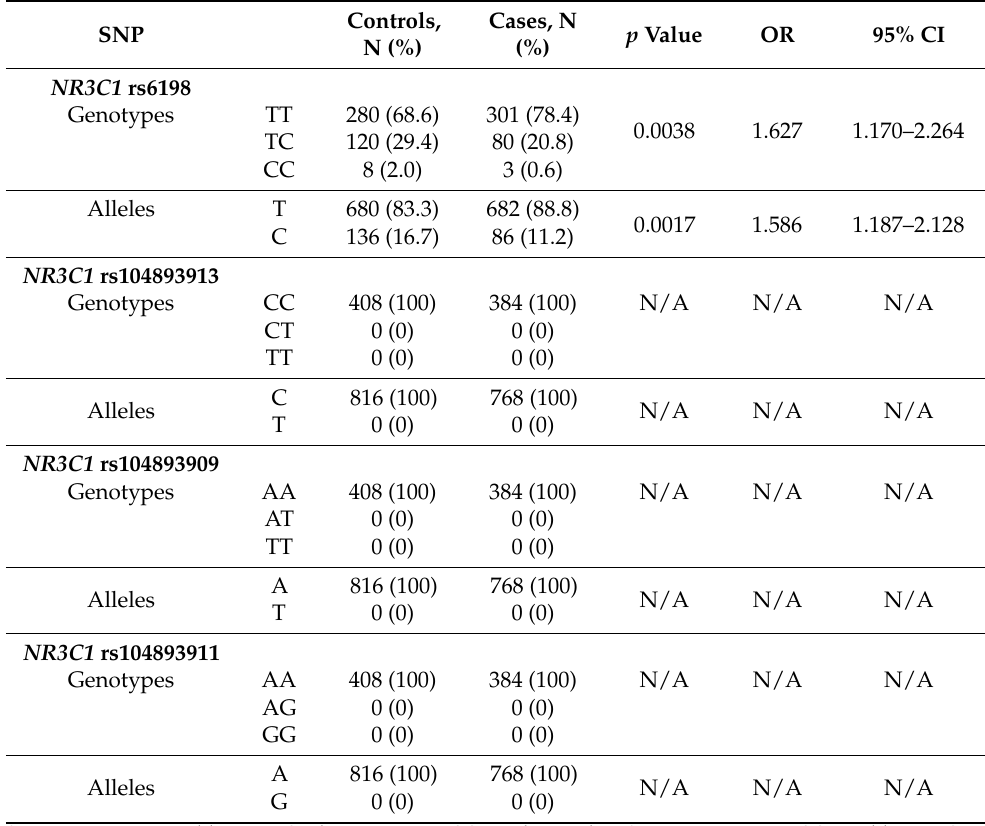
Table 1. Multivariate analysis, adjusted for age, sex, and smoking habits, comparing SNPs of NR3C1 (rs6198, rs104893913, rs104893909, and rs104893911) in 384 Graves’ disease patients and 408